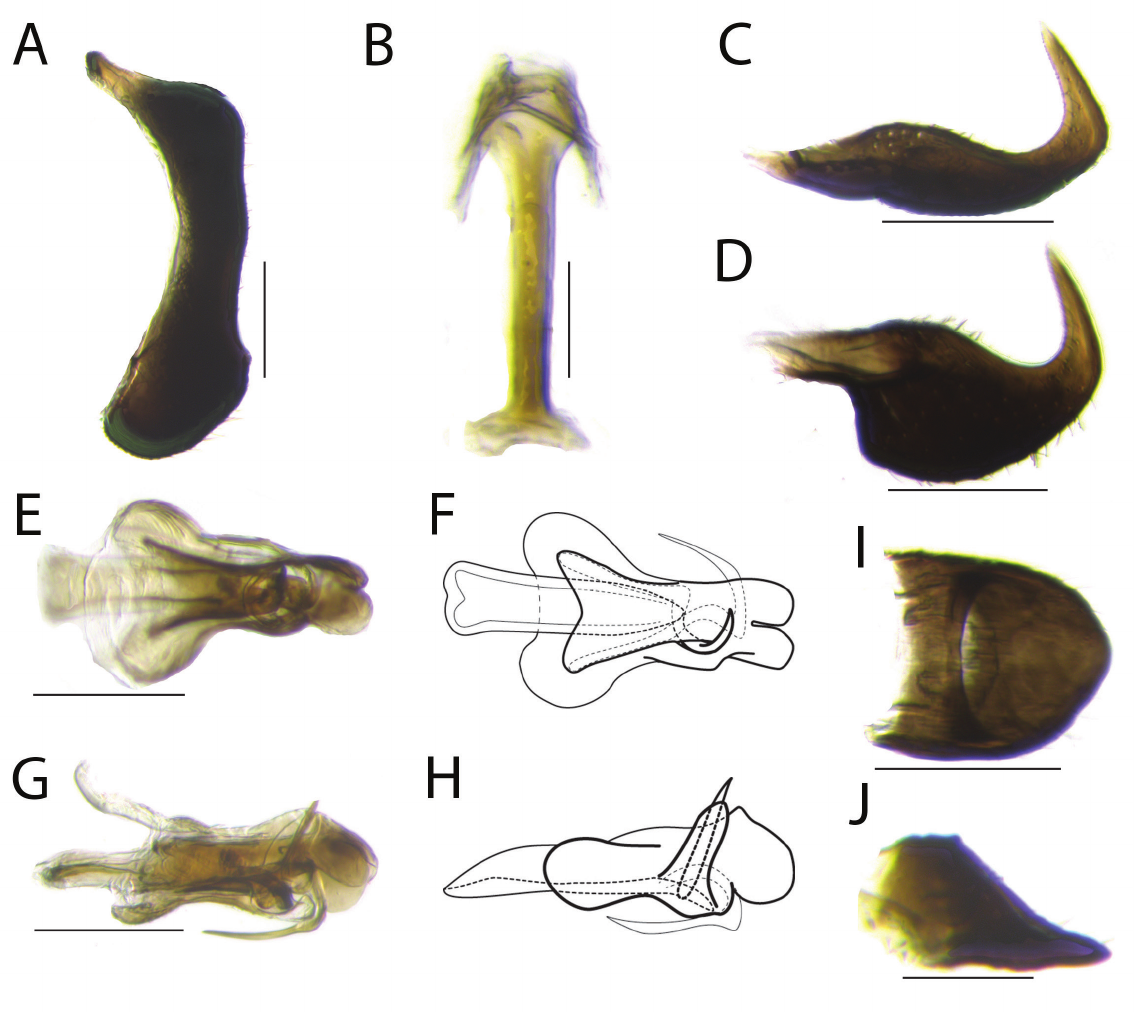
Fig. 7. Male terminalia of Bruchomorpha mormo Kirkaldy, 1907 (DZRJ). A . Pygofer, lateral view. B . Connective, anterior view. C–D . Style. C . Dorsal view. D . Lateral view. E–H . Phallus. E–F . Dorsal view. G–H . Lateral view. I–J . Anal tube. I . Dorsal view. J . Lateral view. Scale bars = 0.1